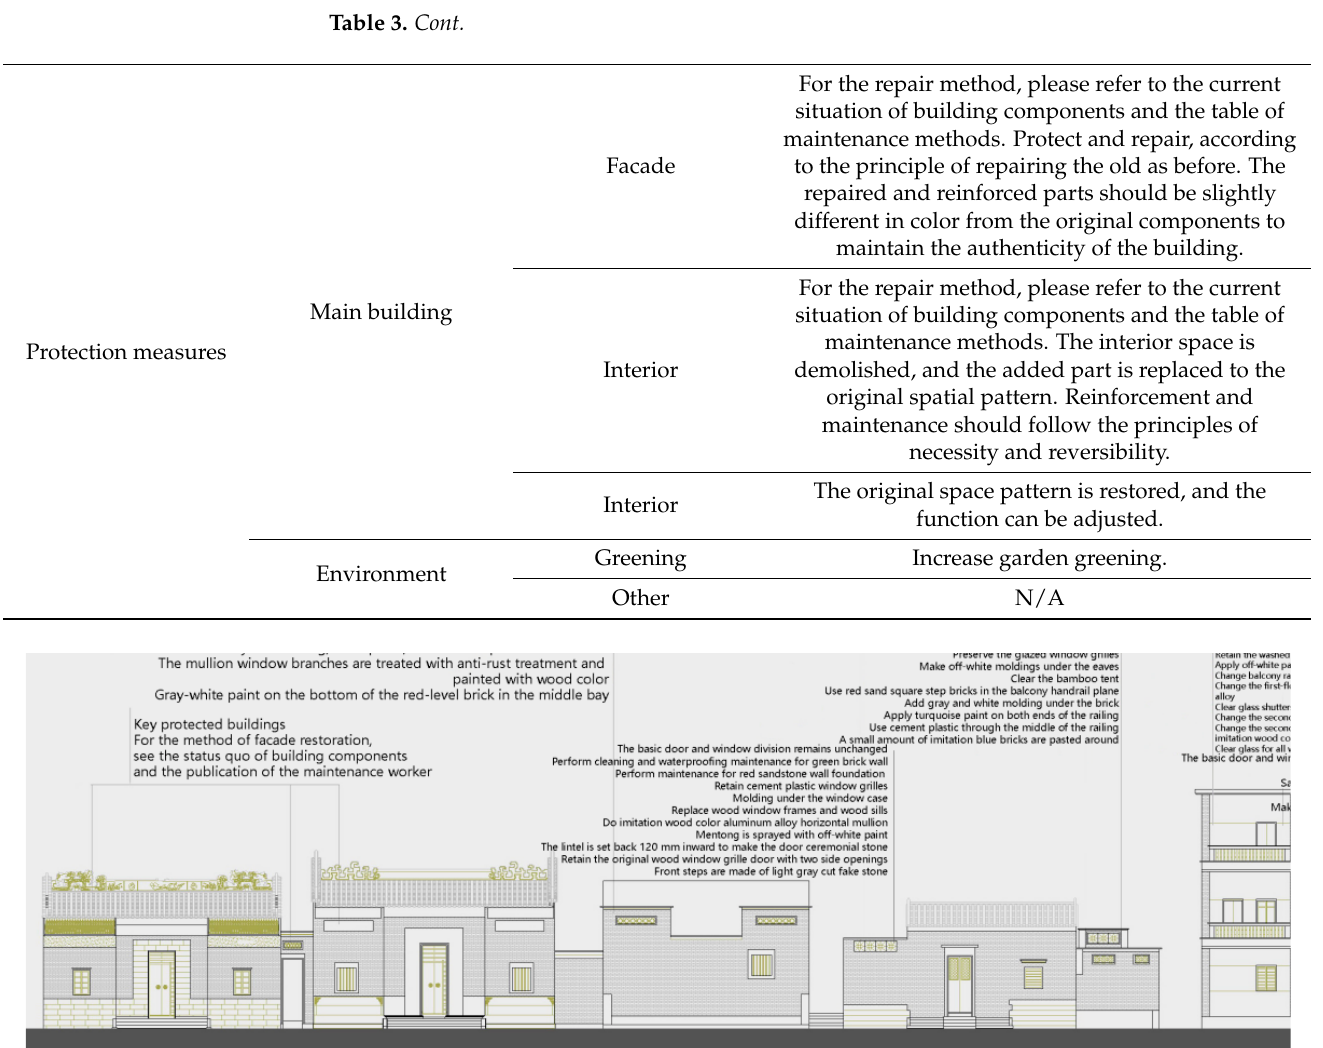
Figure 11. Facade renovation of Chepi Street (Source: [20]).